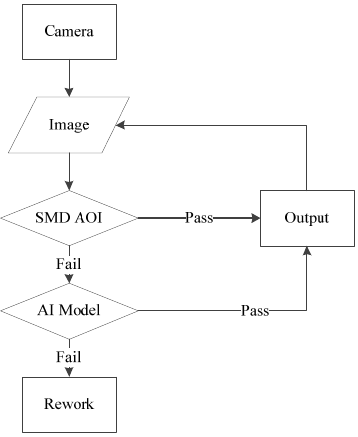
Figure 5. AI judgment